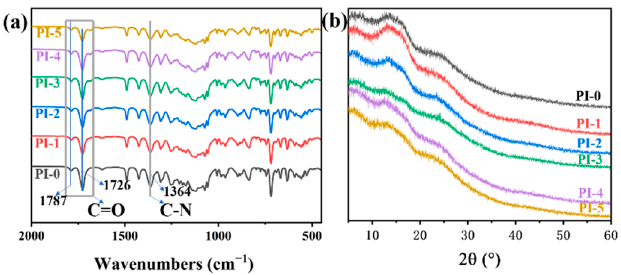
Figure 2. ( a ) The FT-IR spectrum of CPIs; ( b ) The WARD spectrum of